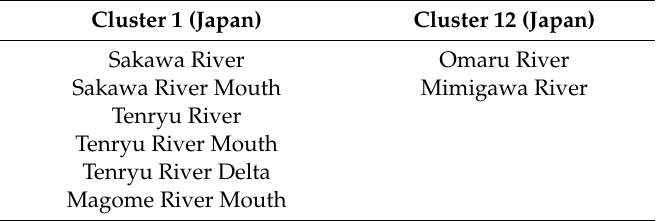
Table 1. Designations and locations of the rivers in the first and twelfth clusters.